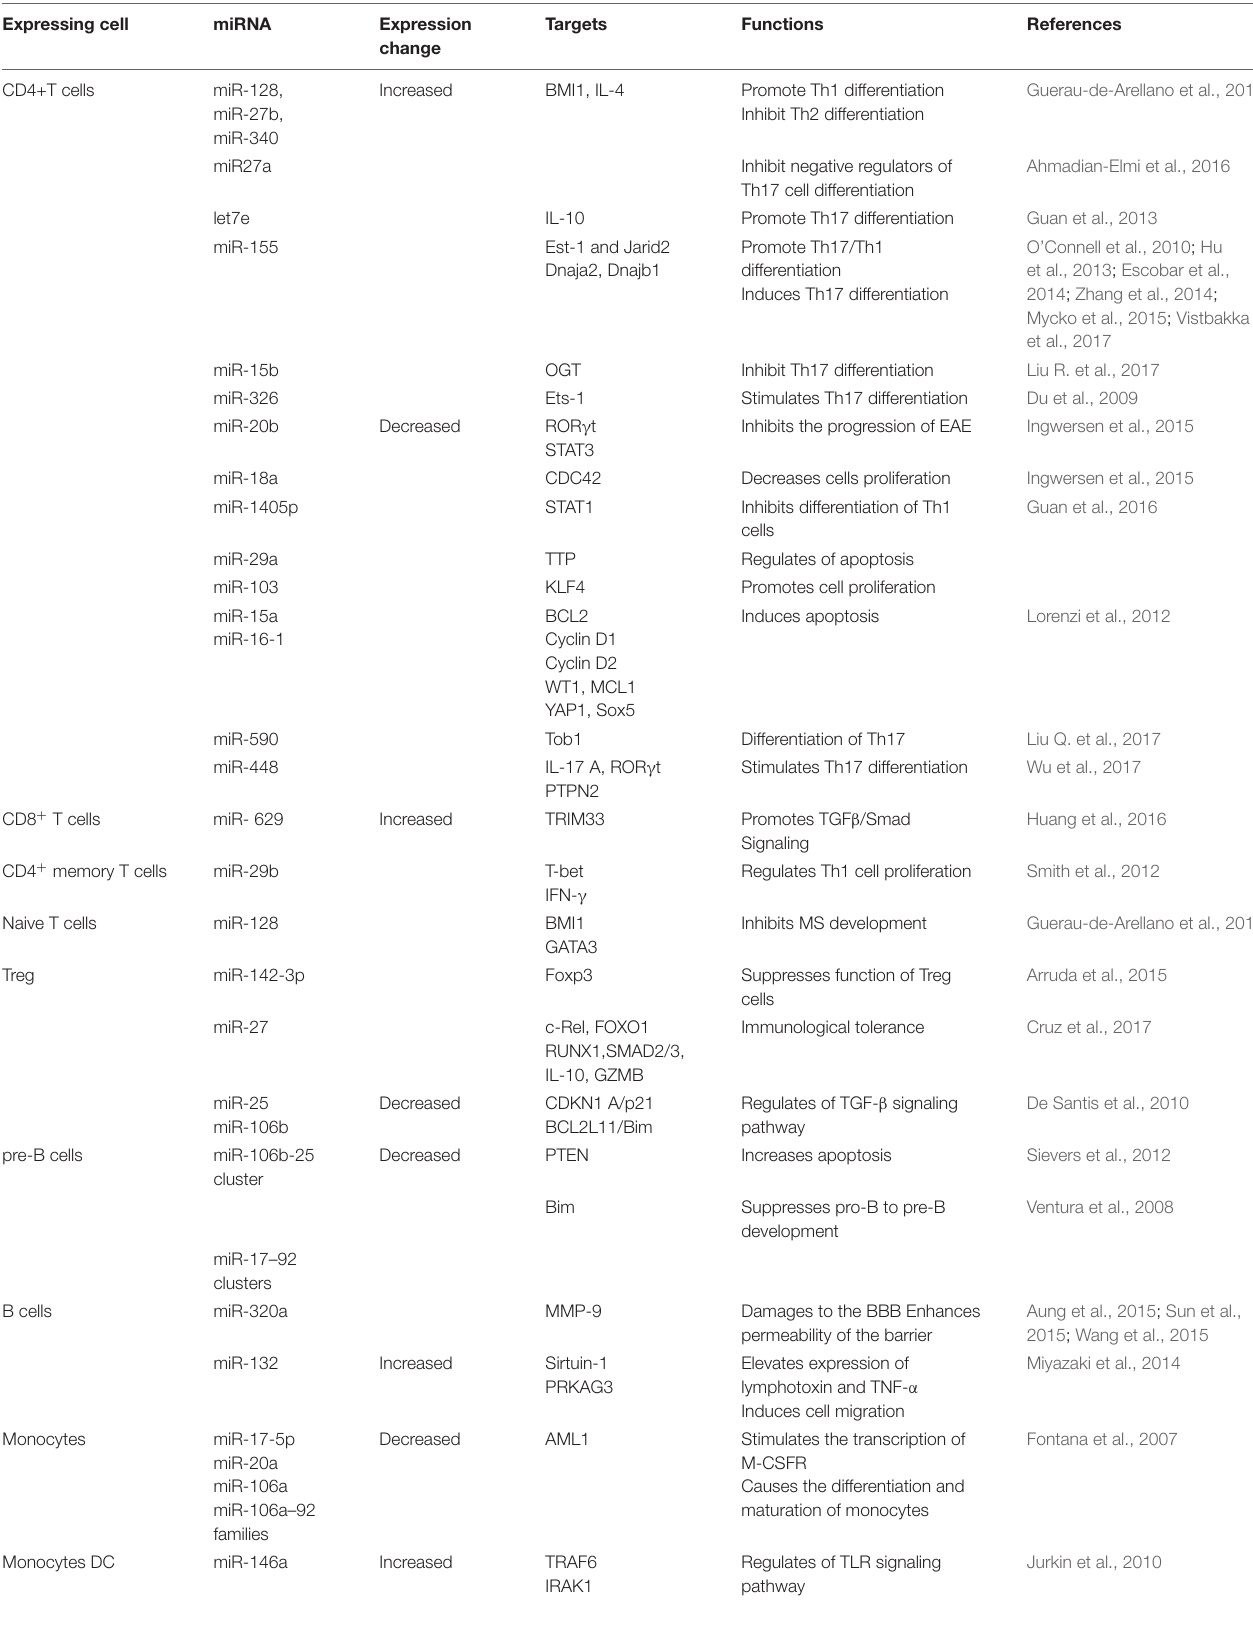
TABLE 1 | Dysregulated miRNAs in T cells, B cells, and monocytes of MS. Expressing cell